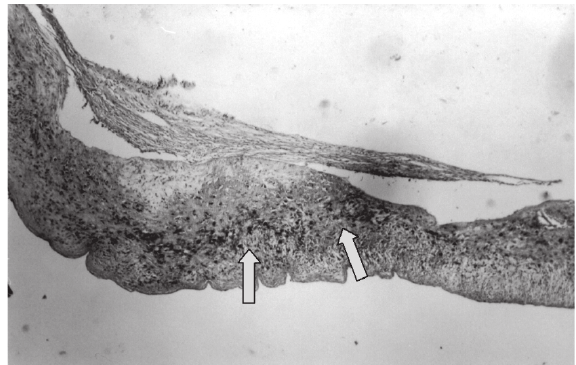
Fig. 6 - Fotomicrografia mostrando corte transversal da cúspide aórtica tratada com etanol 80%, sem sinais de calcificação após 60 dias de implante. E 80% subgrupo 60 dias (H&E 40x).